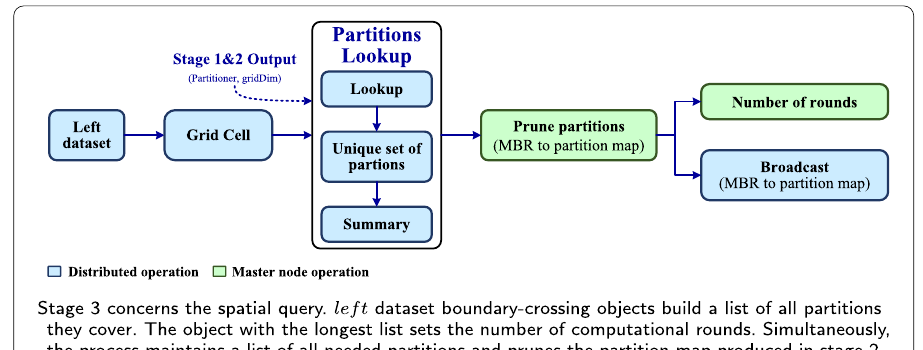
Fig. 7 Stage 3—Pruning and computing the number of computational